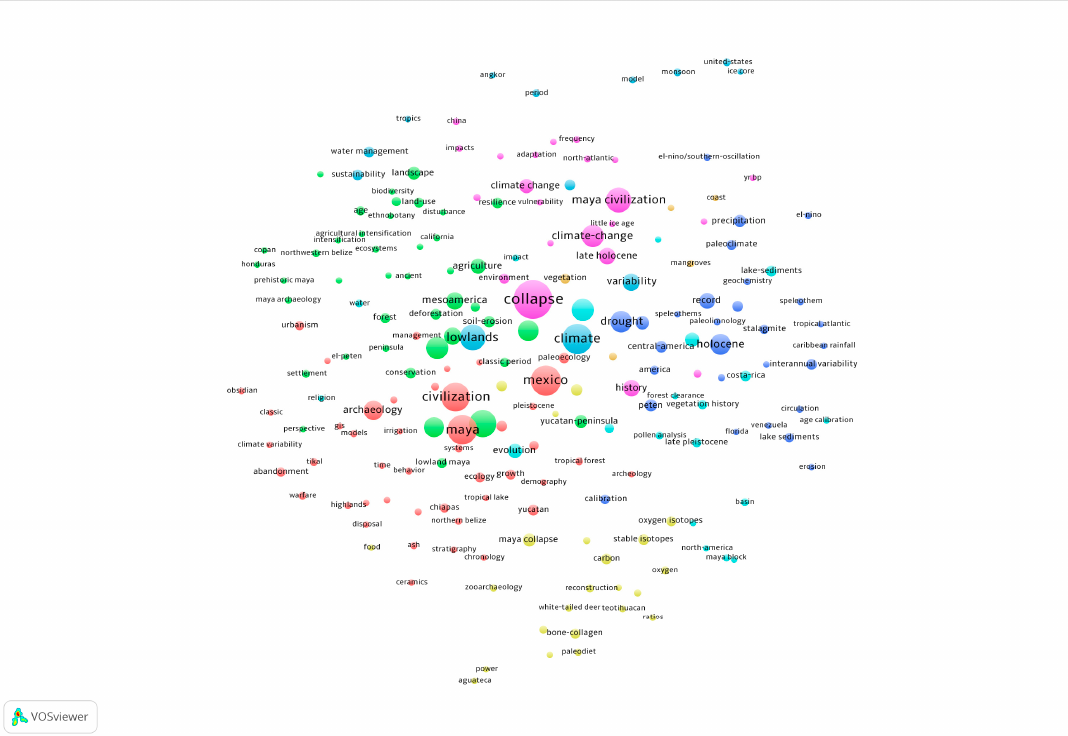
Figure 5. Co-occurrence map of all keywords (author keywords and “keywords plus”, allocated by the database producer) from the 433 Maya collapse papers for content analysis (the minimum number of co-occurrences of a keyword is three). Source: WoS. VOSviewer.